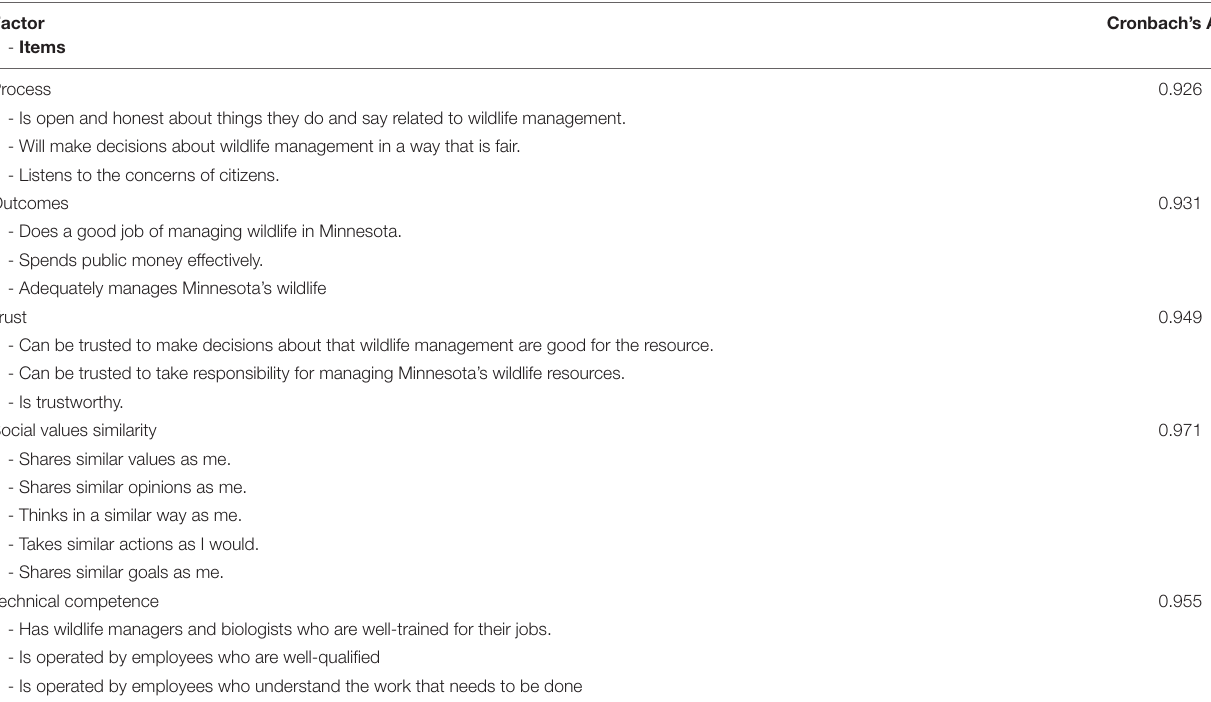
TABLE B1 | Trust survey items adapted from Riley et al. (2018) and Schroeder et al. (2020) 1